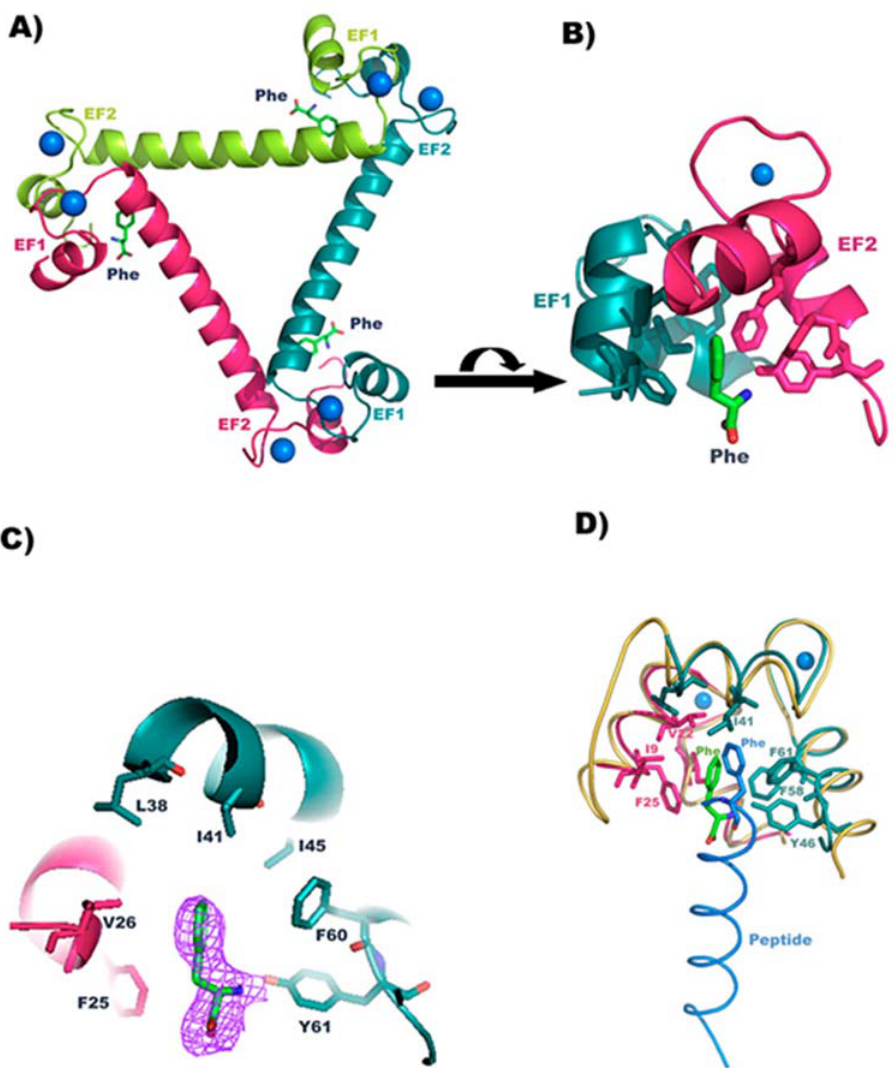
Figure 6. Structural Characterization of EhCaBP1 bound to Phenylalanine molecule. (A)Structure of trimeric EhCaBP1 showing the phenylalanine molecule bound in the hydrophobic pocket formed by the assembled domain. Three molecules interact with each other by head-tail manner forming an assembled domain at the interface. (B) Close view of assembled domain showing phenylalanine in the hydrophobic pocket surrounded by several hydrophobic residues. (C) 2Fo-Fc electron density map of phenylalanine at 2 s level. (D) The N-terminal domain of CaM- peptide complex is superposed on the assembled domain of EhCaBP1-phenylalanine complex. The hydrophobic hankering residue of the peptide in CaM-peptide complex is bound to similar location as Phe in the assembled domain of EF1 of one molecule (hot pink) and EF2 of neighboring molecule (deep teal).